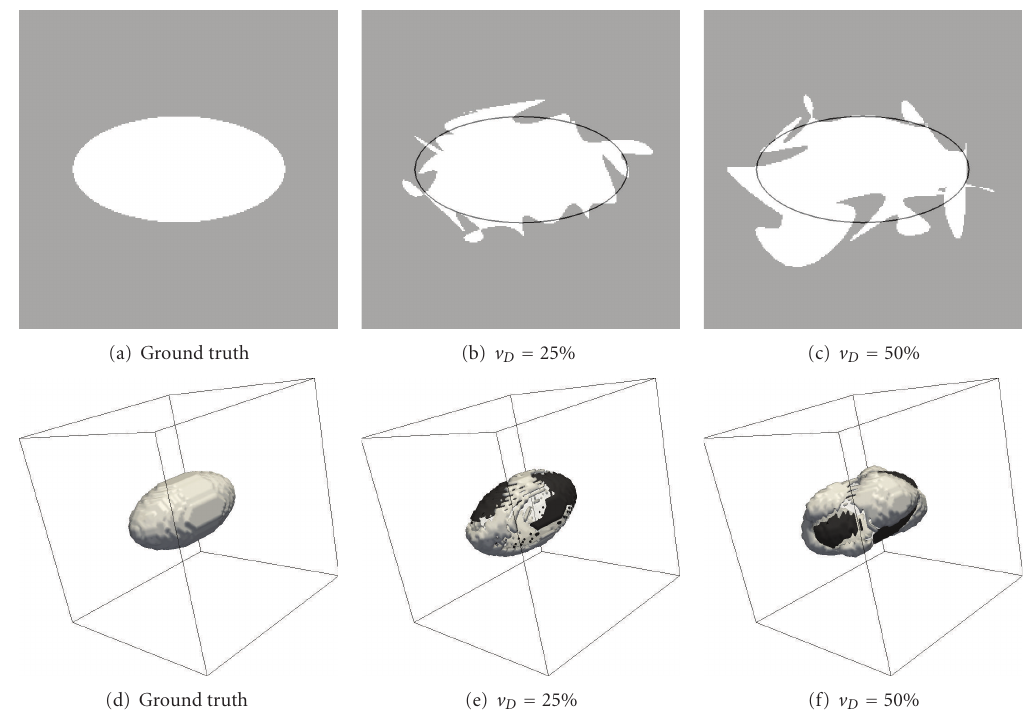
Figure 1: (a, b, and c) 2D and (d, e, and f) 3D simulated images showing the ground truth (a, d), and images with v D of 25% (b, e) and 50% (c, f). White and black surfaces (e, f) represent, respectively, voxels added to or missing from the ground truth. In 2D, the ground truth was an ellipse geometry of radius 1AU (arbitrary units) along the x -axis and 0.5AU along the y -axis, consisting of eight control points, located at constantly separated angles, between which the ellipse was interpolated with cubic splines. We then mapped this geometry on a grid of 256 × 256 pixels between − 1.5 and 1.5AU along both the x - and y -axes. In 3D, the ground-truth image was an ellipsoid geometry of radius 1AU along the x -axis and 0.5AU along both the y - and z -axes, consisting of 26 control points. See text for construction details. The geometry was mapped in a grid of 64 × 64 × 64 voxels between − 1.5 and 1.5AU along each of the three